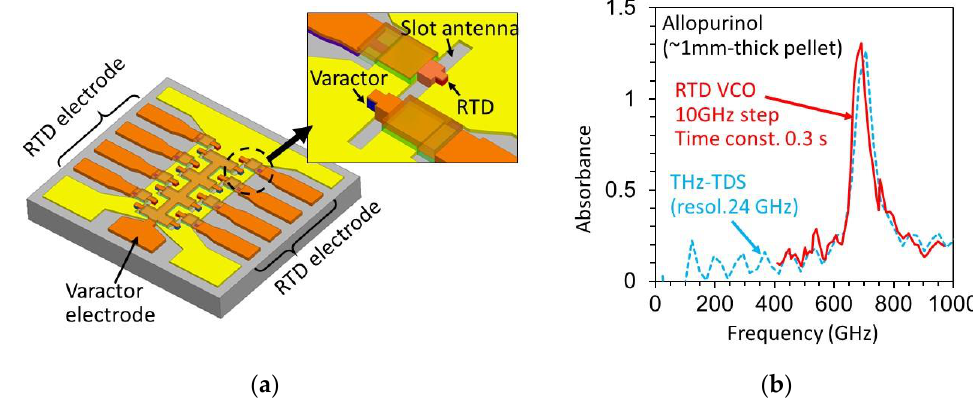
Figure 9. Frequency-tunable RTD oscillator and application to absorbance measurement: ( a ) Array of frequency-tunable oscillators integrated with varactor diodes, and ( b ) absorbance measured by RTD oscillators together with the result of THz time-domain spectroscopy (TDS) measurement. Copyright (2017) The Japan Society of Applied Physics